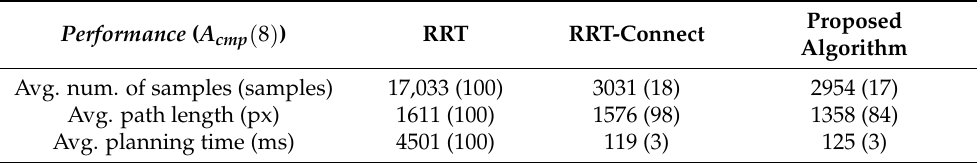
Table 9. Experimental result of Map 8 (The parentheses to the right of each value are the relative ratios based on RRT 100% ( x cmp ( 8 ) )).